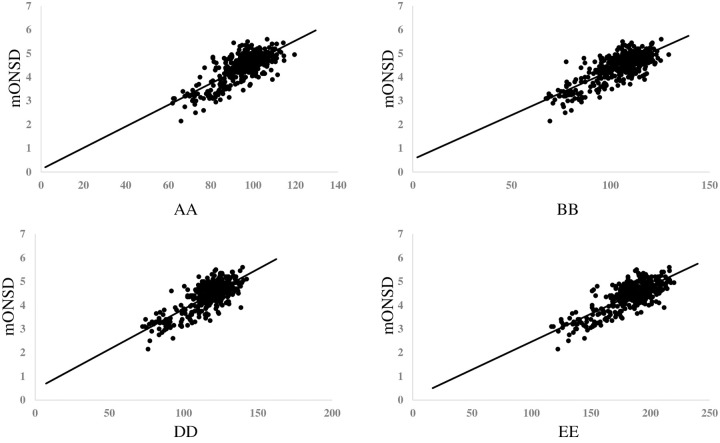
Mean optic nerve sheath diameter of those in normal control plotted in relation to width of the brain, revealing that mONSD was linearly correlated with AA-EE, respectively.Results of regression analysis and Spearman’s rank correlation analysis is shown in separate table. mONSD; mean optic nerve sheath diameter, AA, BB and DD; corresponding brain width to maximum distance between anterior horn, minimum bicaudate nuclei distance, third ventricle distance, respectively, EE: a square root of summation for AA2, BB2, and DD2, ρ; Spearman’s rank correlation coefficient.